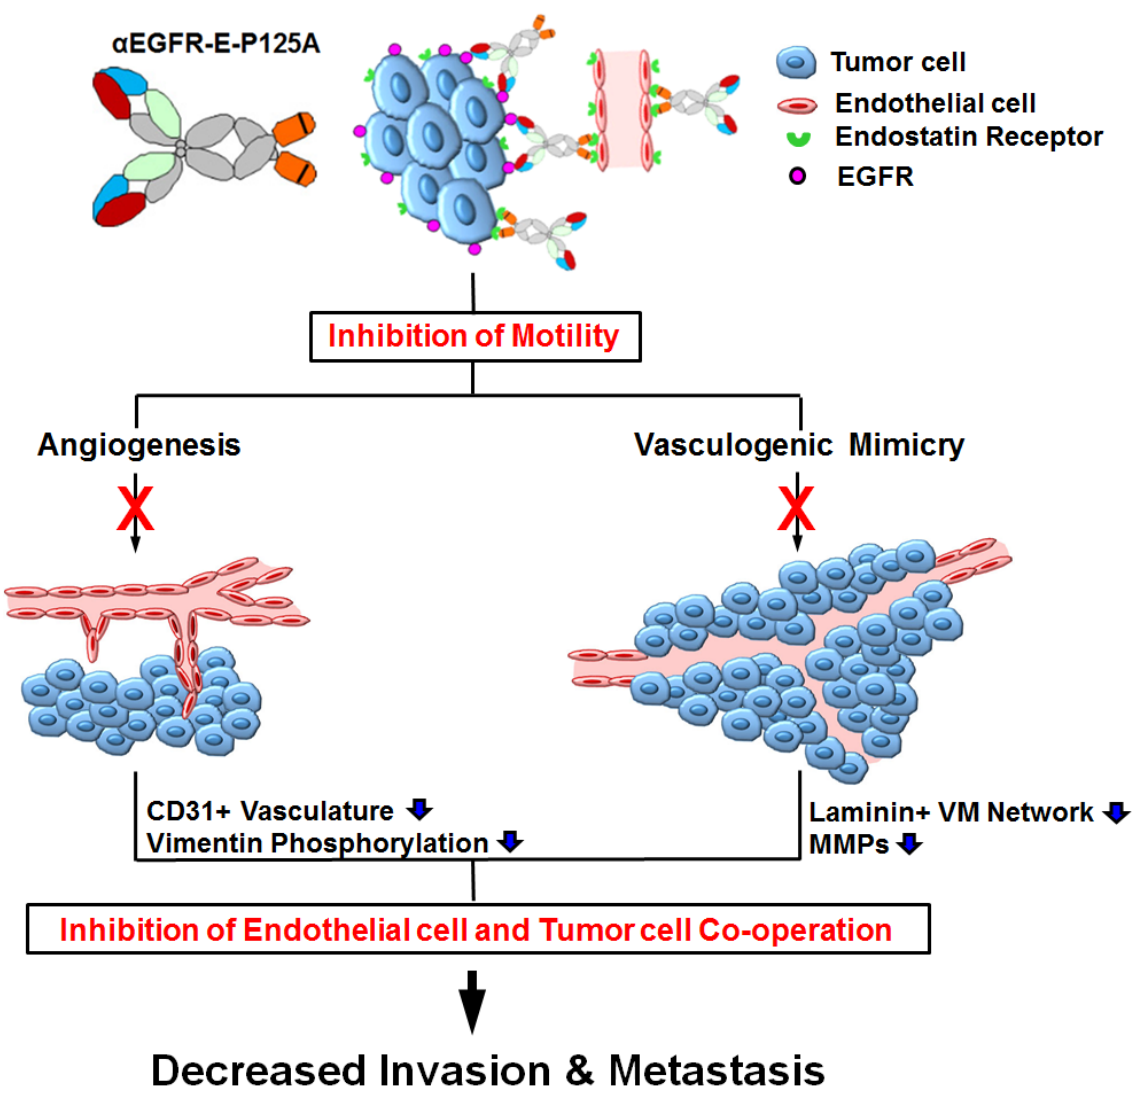
Figure 6. α EGFR-E-P125A effects on angiogenesis and VM lead to decreased tumor growth and metastasis: α EGFR-E-P125A reduces TNBC motility and migration, leading to decreased circulating tumor cells. Assembly of tumor blood vessels (angiogenesis) by endothelial precursors and tumor cell-lined vascular channels (VM) are both inhibited, reducing tumor growth and metastasis.